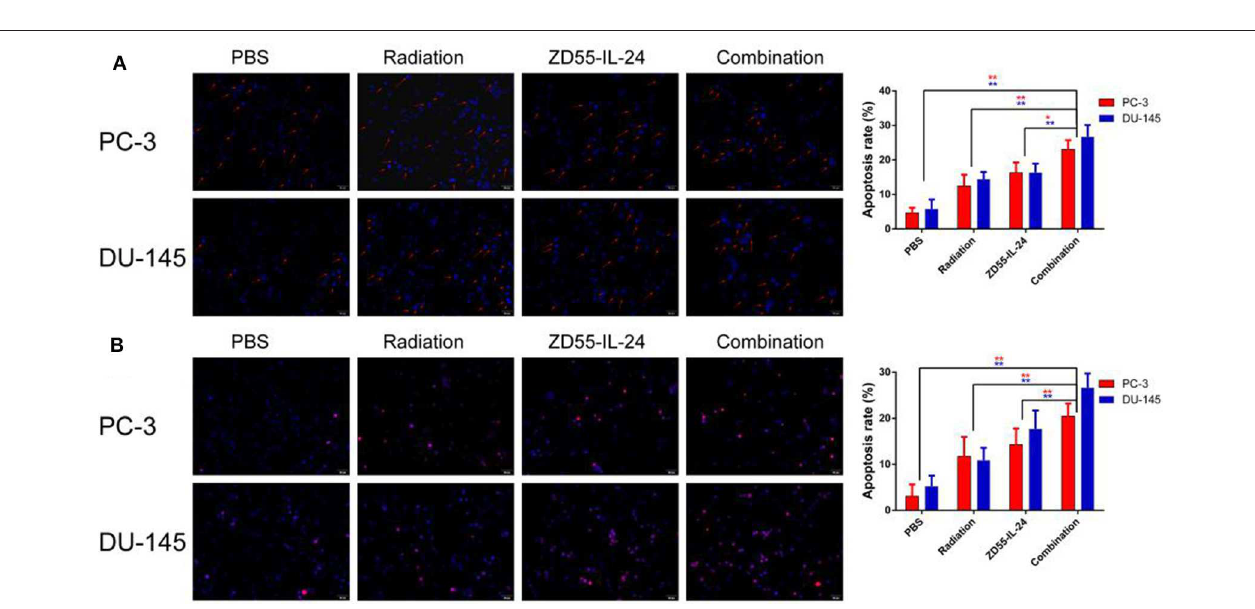
FIGURE 1 | The proliferation of PC-3 and DU-145 cells exposed to ZD55-IL-24 or/and radiation. (A) Different titers of ZD55-IL-24 inhibited the proliferation of PC-3 cells. (B) Different titers of ZD55-IL-24 inhibited the proliferation of DU-145 cells. (C) Different doses of radiation inhibited the proliferation of PC-3 and DU-145 cells.